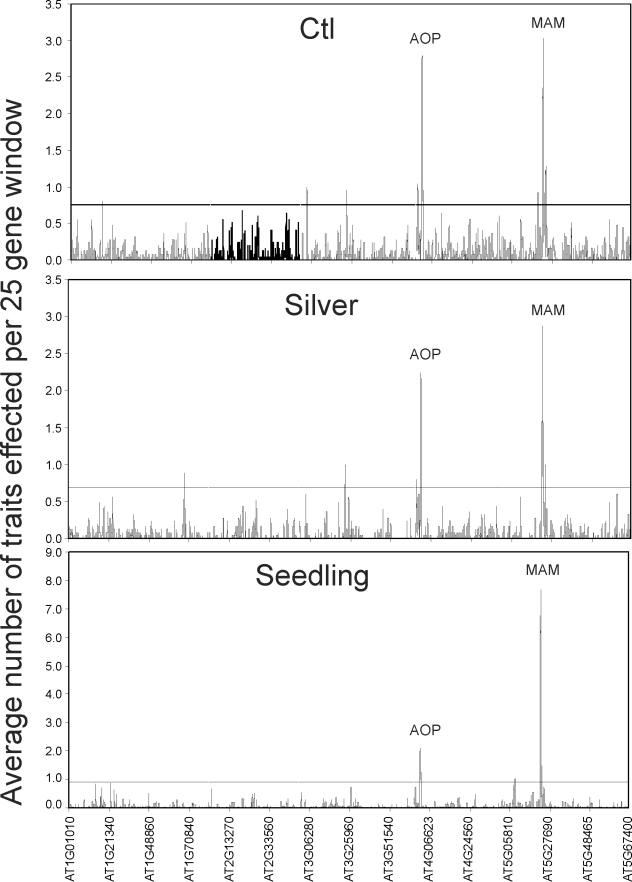
Genomic hotspots of GWA positive candidate genes.A 25-gene sliding window analysis was done to survey the genomic distribution of genes with significant associations to the different GSL traits in the three datasets. The sliding window took the average number of traits affected across every 25 genes such that a value above 1 within a 25-gene window implies each gene in the window affects one GSL trait. The horizontal line represents the 95% percentile value for a 25 gene window from 1,000 random bootstrap analyses that randomly shuffled the gene's position within the genome for each dataset. All five chromosomes are shown in contiguous order on the x-axis with the position labeled using the AGI gene code.